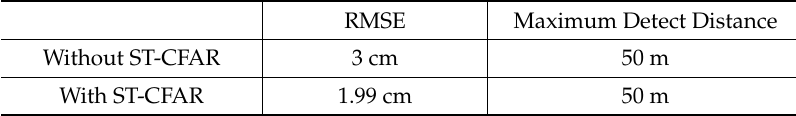
Table 5. Results of applying the ST-CFAR